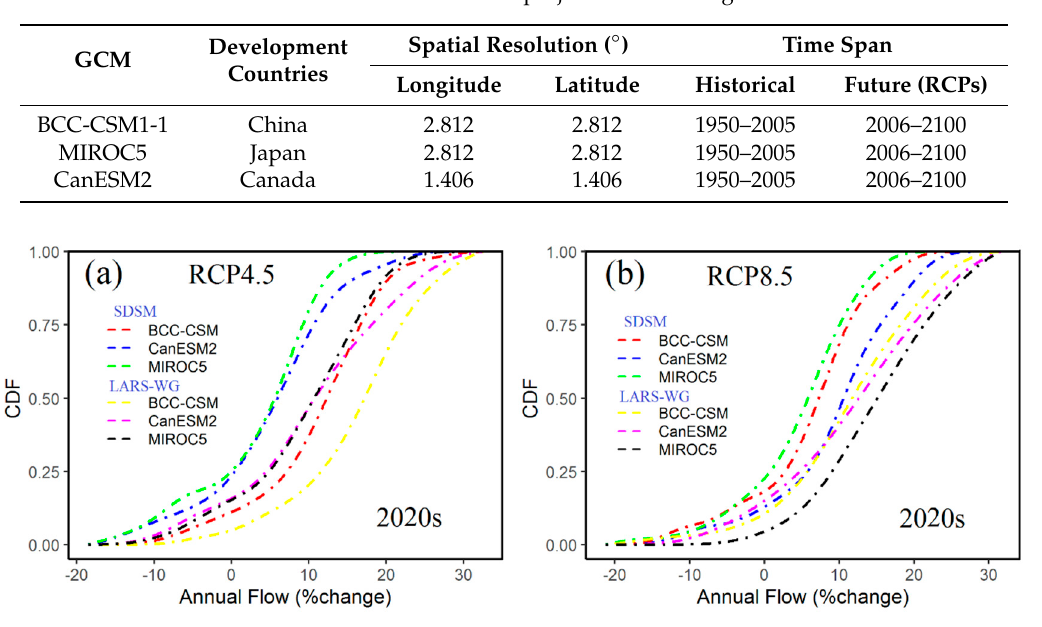
Figure A1. CDFs of annual changes in flow under ( a ) RCP4.5 and ( b ) RCP8.5 between the period Table A2. Model performance rating based on Moriasi et al. [33].